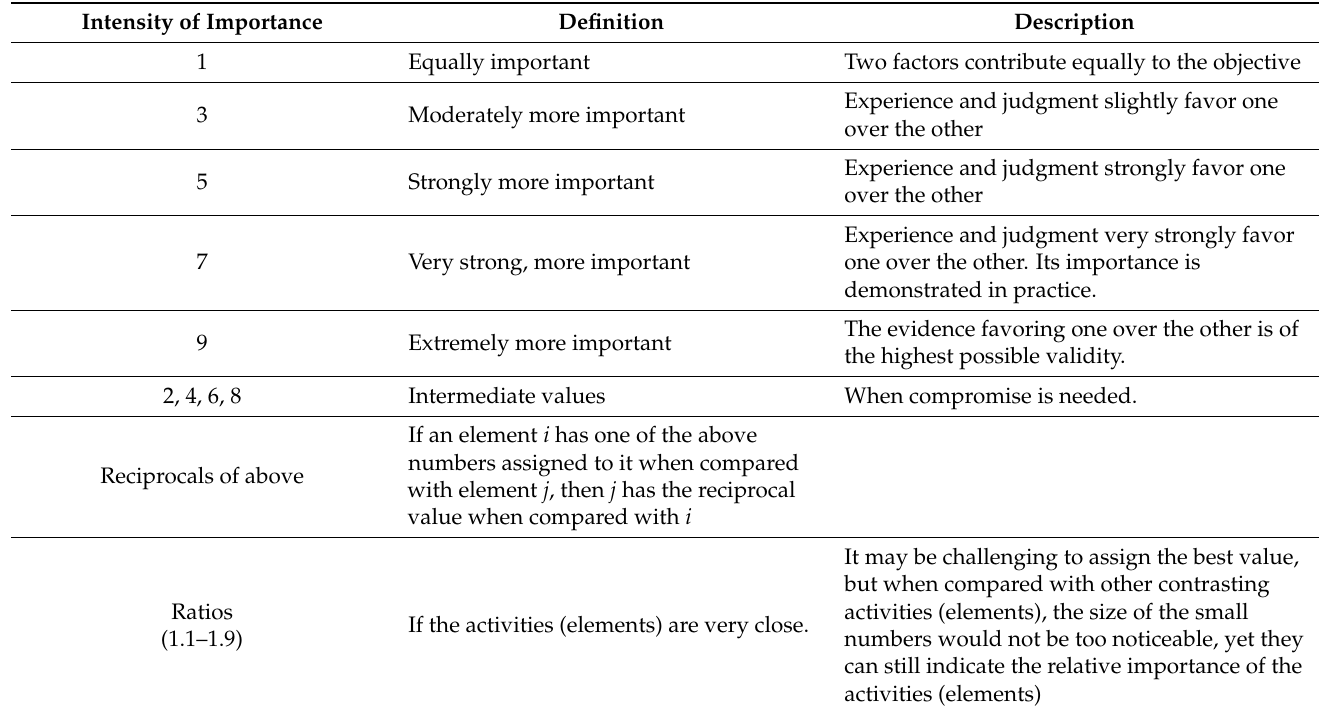
Table A1. The nine-point intensity of importance scale was modified from Schoenherr. Copyright 2008